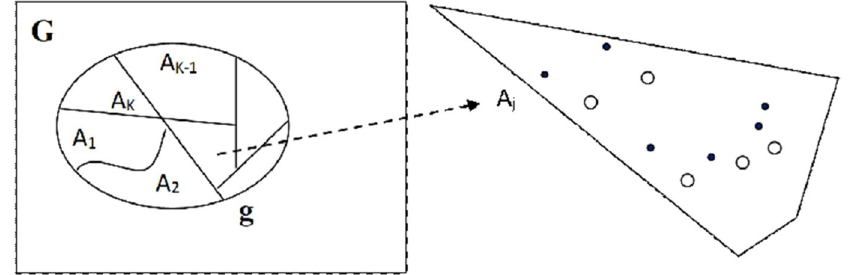
Figure 1. A scheme for investigated region g with partition {A j } and reference population G . In some A j , for example, a black dot denotes the “spot” of an outbreak farm while a circle represents a non-outbreak. Within a defined period, there were a total of T j poultry farms with N j outbreaks. Notice that if A j is the focus and assuming heterogeneity, g can also be the